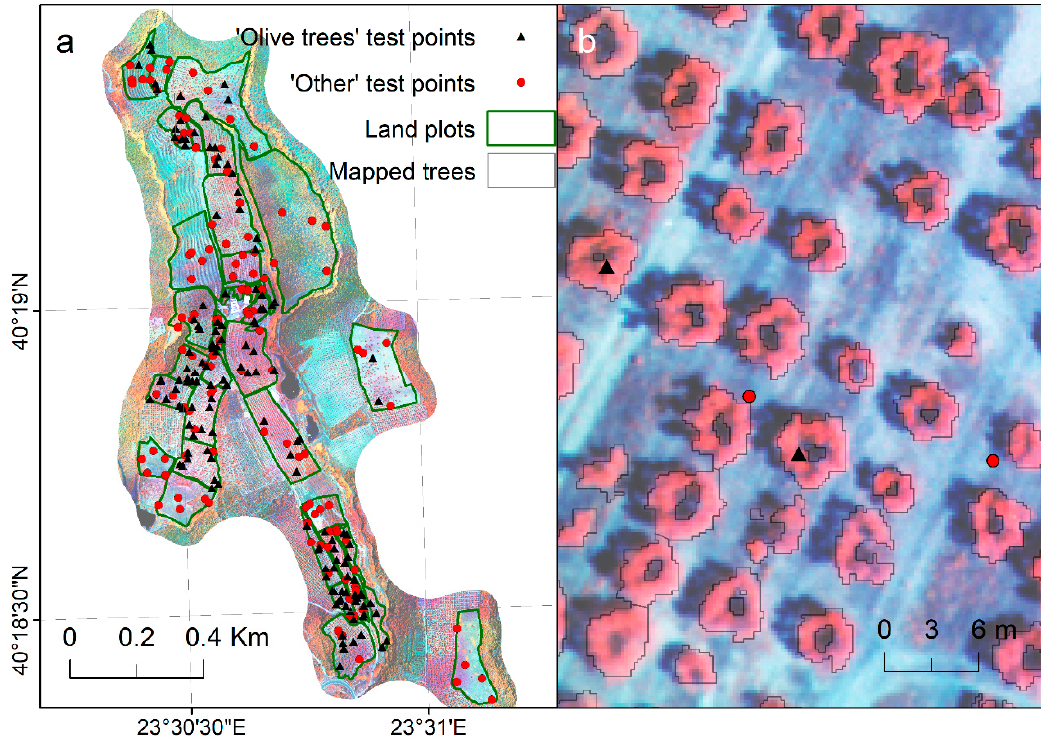
Figure 4. The sampling scheme for the thematic accuracy test: ( a ) an overview of the test points throughout the olive plantation; ( b ) a close view of the samples in relation to tested features.